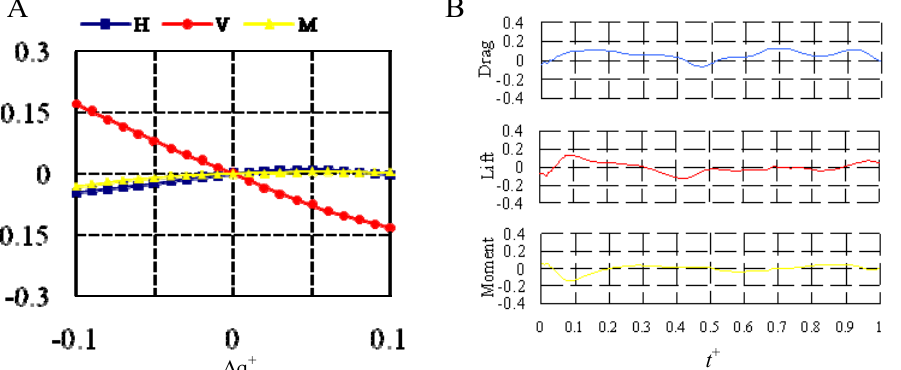
Fig. 7 (A) x -component and z -component of forces and pitching moment when the pitching angular velocity q varies in a range of -0.1~0.1. (B) Time course of the differences in lift, drag and pitching moment with respect to the reference flight condition at Δ q + =0.06 . t + is a dimensionless